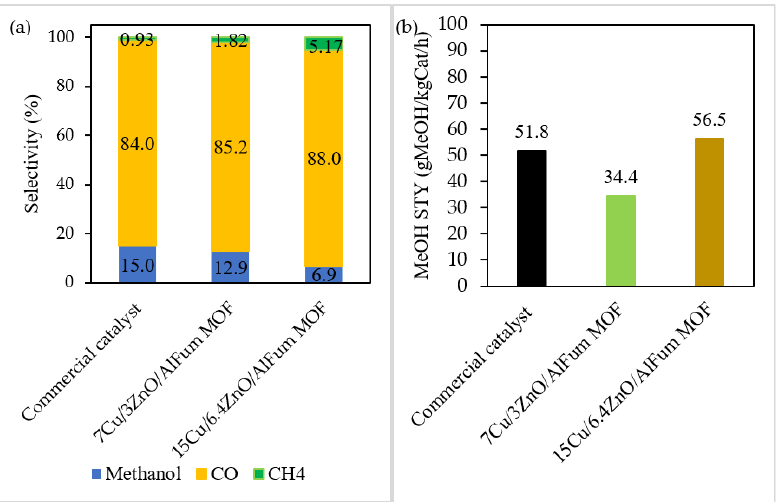
Figure 7. ( a ) MeOH, CO, and CH 4 selectivity and ( b ) MeOH space-time yield of all the tested cata-